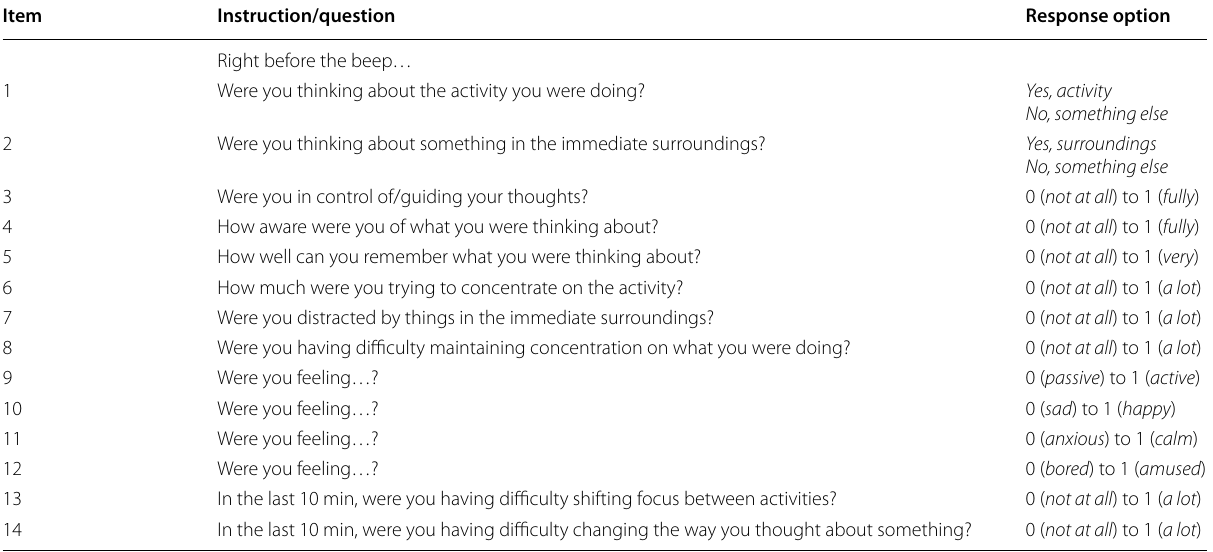
All 0–1 response scales were 100‑point visual analog